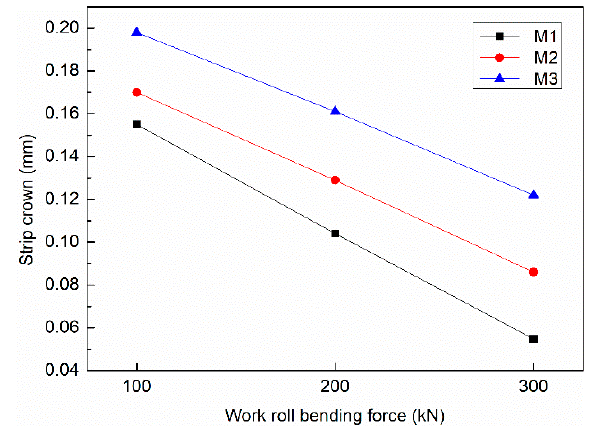
Figure 11. The strip crown of stand 4 under different load distribution.